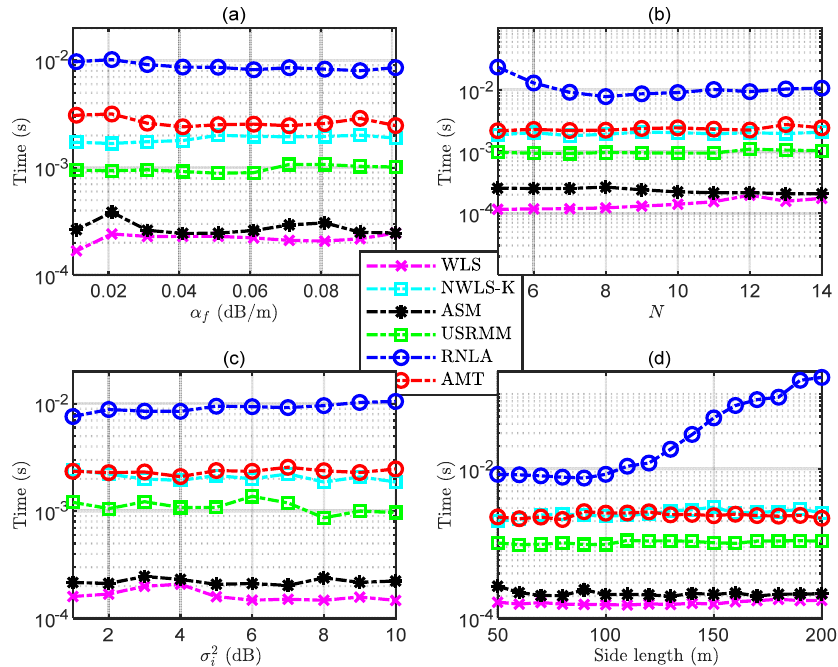
Figure 11. Computational time comparisons under di ff erent conditions: ( a ) Computational time under variable α f with P 0 = − 55 dBm, N = 10, σ 2 ( b ) computational time under variable N with P 0 = − 55 dBm, σ 2 side length of the cube Side = 50 m, ( c ) computational time under variable σ 2 N = 10, α f = 0.06 dB/m, and the side length of the cube Side = 50 m, and ( d ) computational time under variable side length with N = 10, σ 2